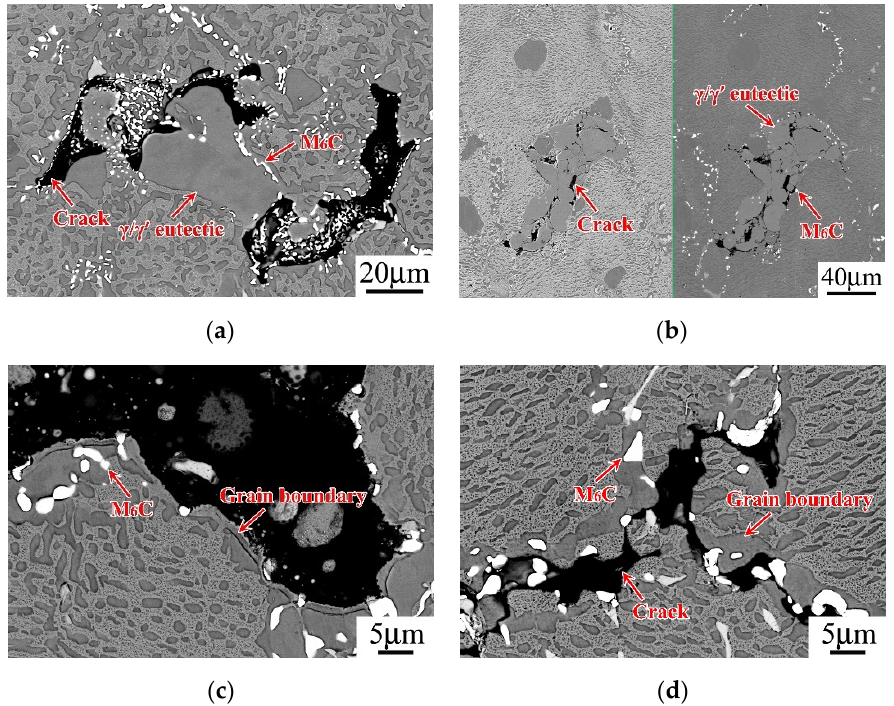
Figure 4. SEM-BSE images of the creep cracks at the longitudinal sections close to the fracture surface of stress rupture specimens of K465 superalloy when creep under (900 °C/30 min–1100 °C/3 min)/50 MPa ( a ), (900 °C/30 min–1150 °C/3 min)/50 MPa ( b , c ), and (1000 °C/30 min–1150 °C/3 min)/50 MPa ( d ).